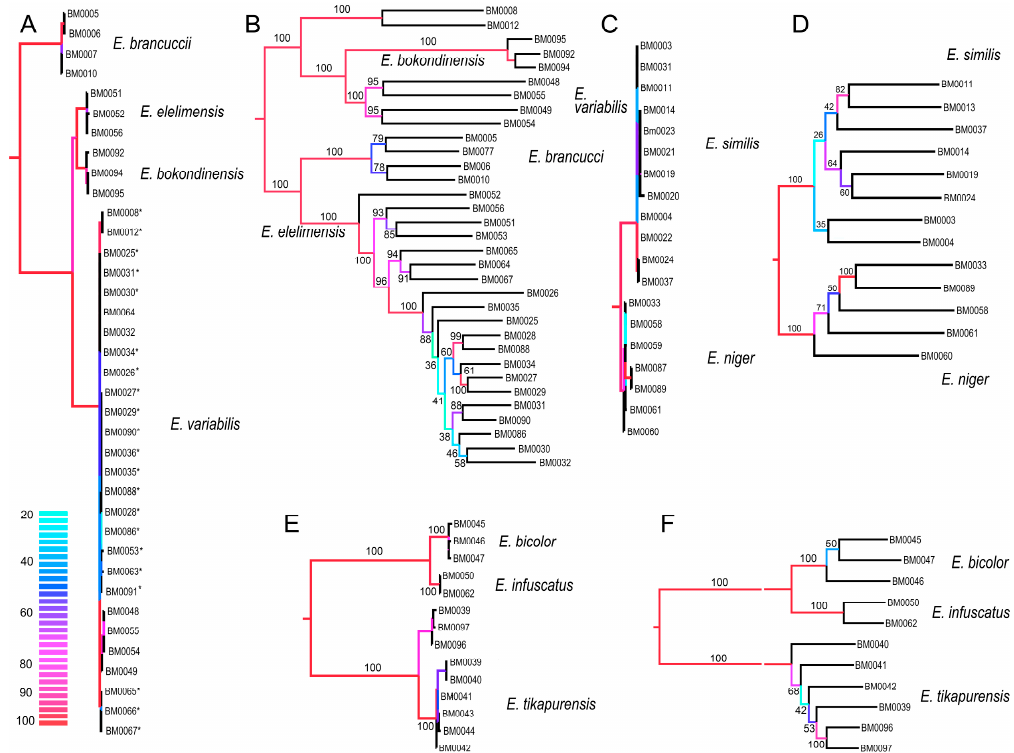
Figure 4. ( A , C , E ) Phylogenetic relationships recovered by the analysis of the concatenated mitochondrial DNA dataset; ( B , D , F ) The phylogenetic relationships recovered by the analysis of the RAD dataset when data for each clade are separately filtered and analyzed (Wclust = 0.85, MinCov = 4). Values at branches designate ultrafast bootstrap values. ( C ) The dated phylogenetic tree based on mutation rates of three mitochondrial fragments; ( D , E ) The geographic position of sampled localities. The color scale designates ultrafast bootstrap values in mtDNA topologies.